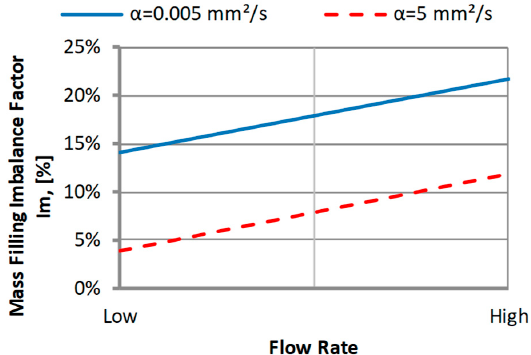
Figure 16. Velocity distribution for different power law index at high injection rate: ( a ) n = 0.1, and ( b ) n = 0.9.